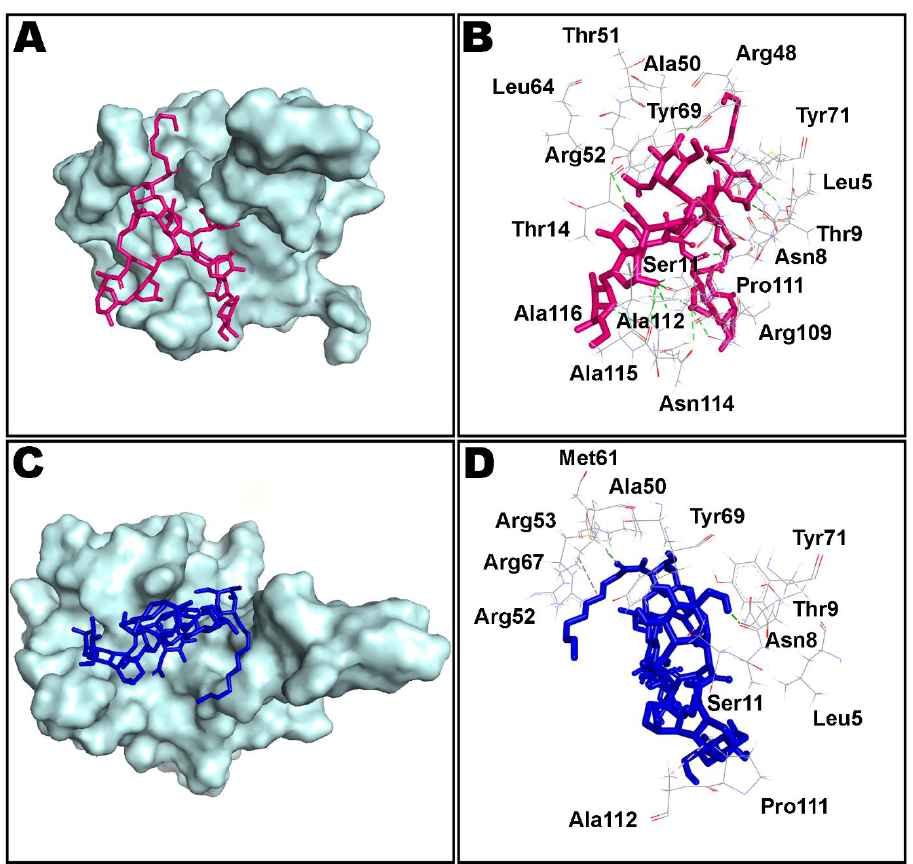
Figure 8. Non-bond interactions observed in first ( A , B ) and last ( C , D ) frames extracted from 100 ns molecular dynamics simulation of teicoplanin bound nucleocapsid protein N-domain of SARS-CoV-2. Ala: alanine; Arg: arginine; Asn: asparagine; Leu: leucine; Met: methionine; Pro: proline; Ser: serine; Thr: threonine; Tyr: tyrosine. The number of corresponding amino acid residue is in accordance with the crystallographic information obtained from the protein data bank.